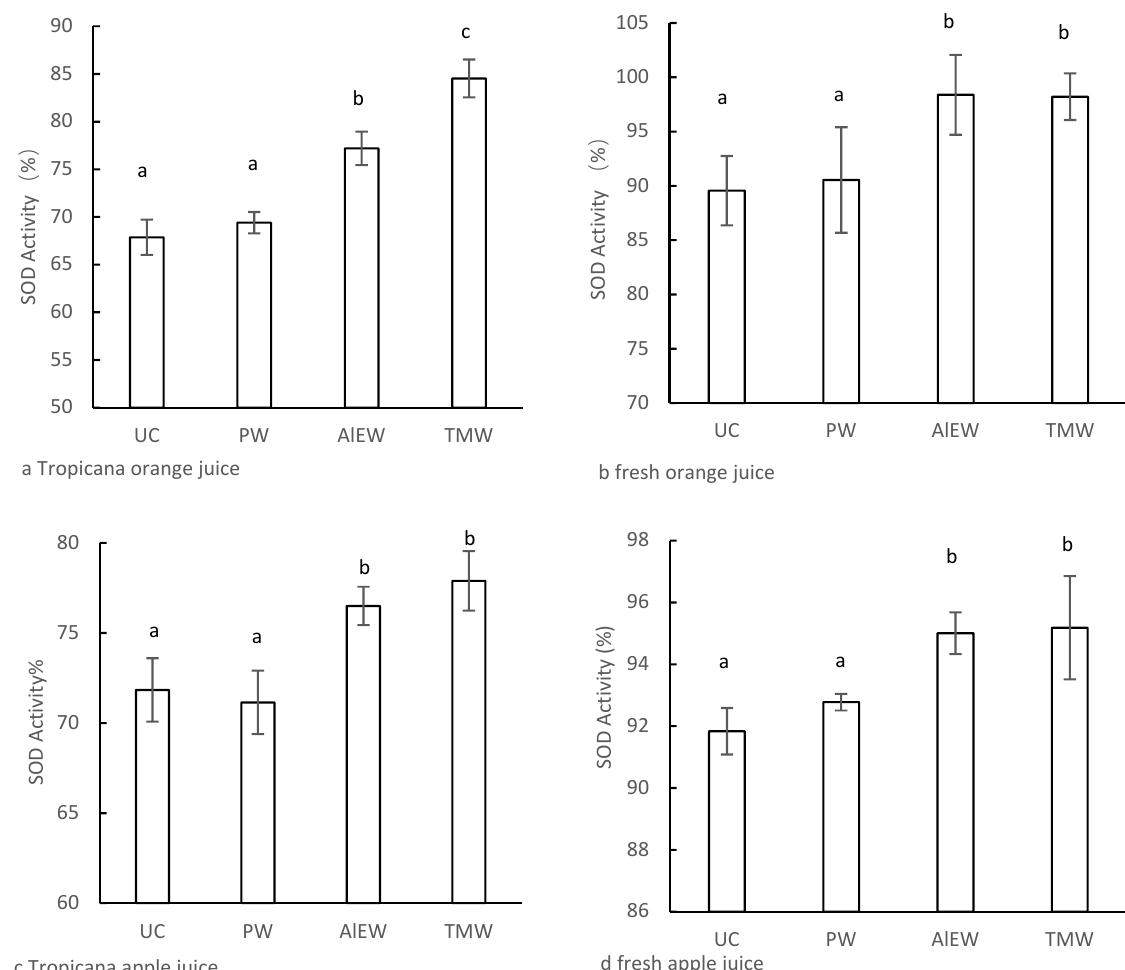
Figure 4. The effect of AlEW and TMW on SOD activity of concentrated reconstituted juice; ( a ) Tropicana orange juice; ( b ) freshly squeezed orange juice; ( c ) Tropicana apple juice; ( d ) Freshly squeezed apple juice. UC is unconcentrated juice; PW is pure water; AlEW is the alkaline electro- lyzed water with an electrolysis current of 8 A; TMW is the tourmaline water produced when the treatment temperature of tourmaline stone is 75 °C. The different letters indicated significant differ- ence ( p < 0.05).